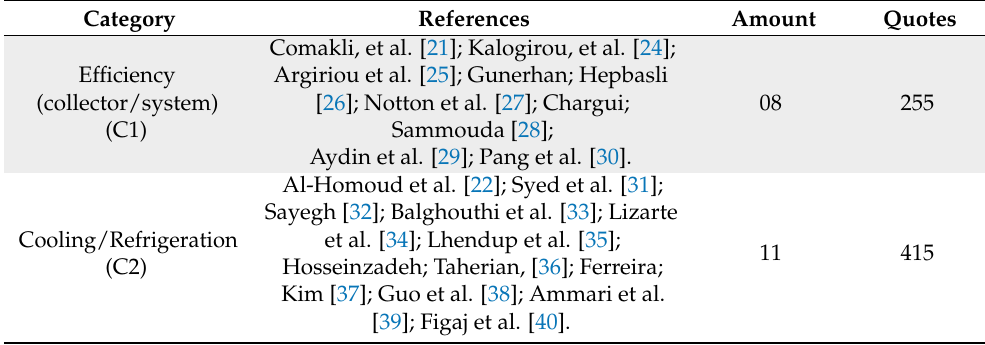
Table 1. Overview of solar heating